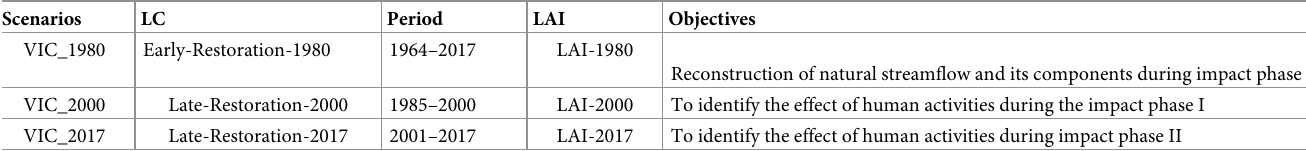
Table 1. Simulation scenarios for detecting climate variability and human activity on streamflow and its components.